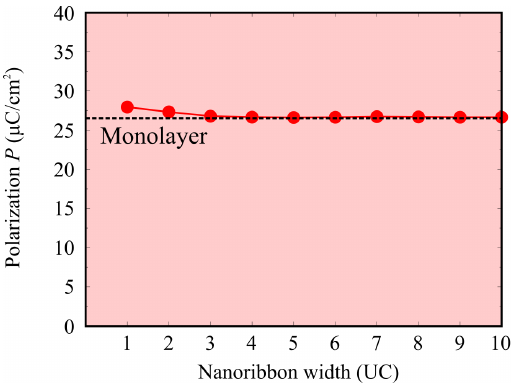
Figure 4. Polarization P in SnTe nanoribbon as a function of the width. The red dotted line shows the ferroelectric polarization of 2D SnTe monolayer. UC denotes the unit cells.